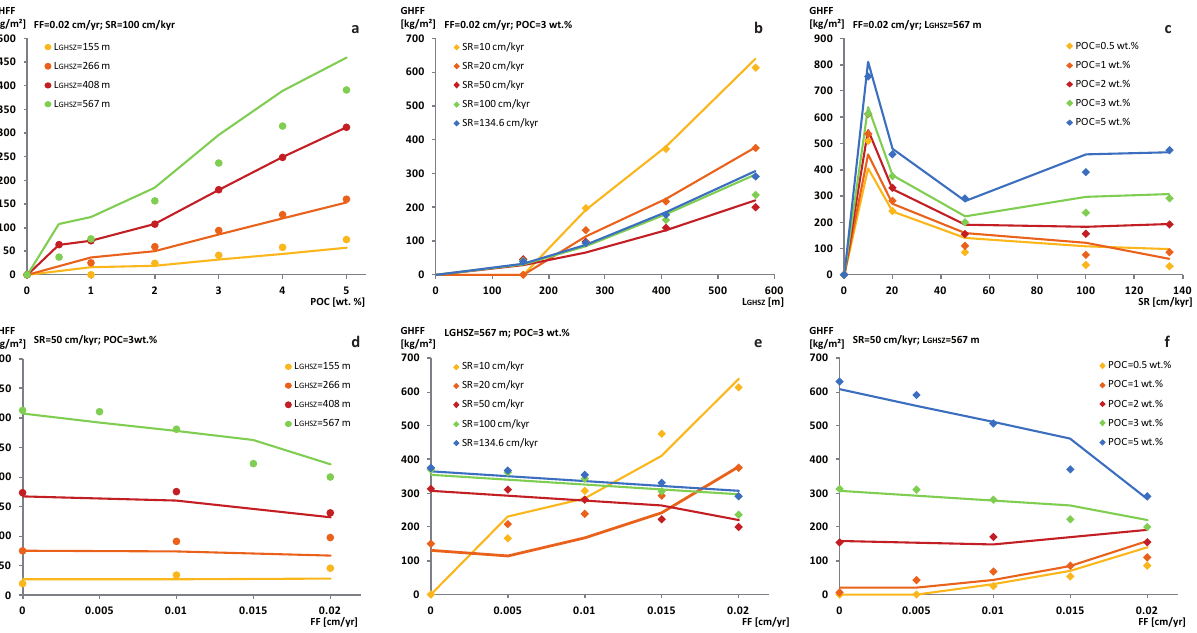
Fig. 7. Parameter analysis of the four control parameters SR, POC, thickness of the gas hydrate stability zone ( L GHSZ ) and fluid flow (FF) for gas hydrate formation. The plots show the results of the model-runs as dots, and the results of Eq. (8) as lines. The plots in the second row (d–f) show the effects of FF on the gas hydrate accumulation in relation to L GHSZ , SR and POC, for constant values of SR and POC, L GHSZ and POC and SR and L GHSZ , respectively.